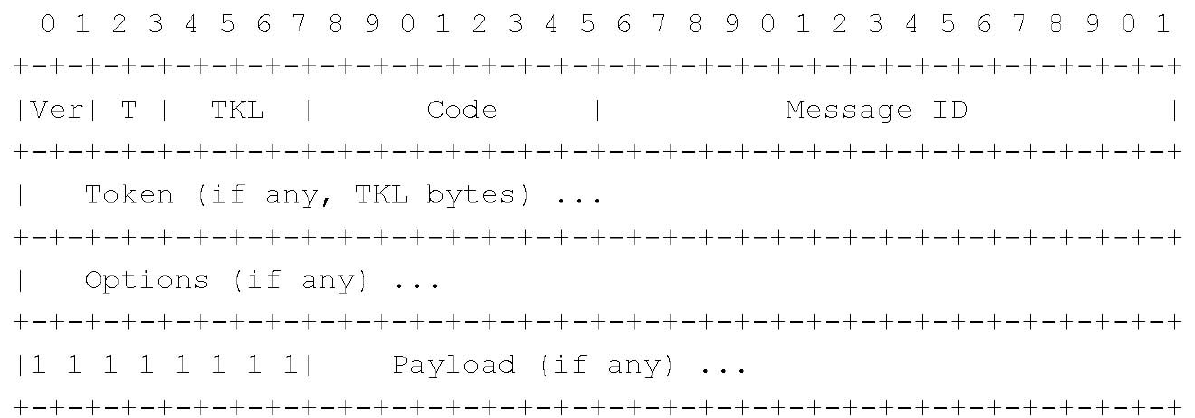
Figure 2. Message